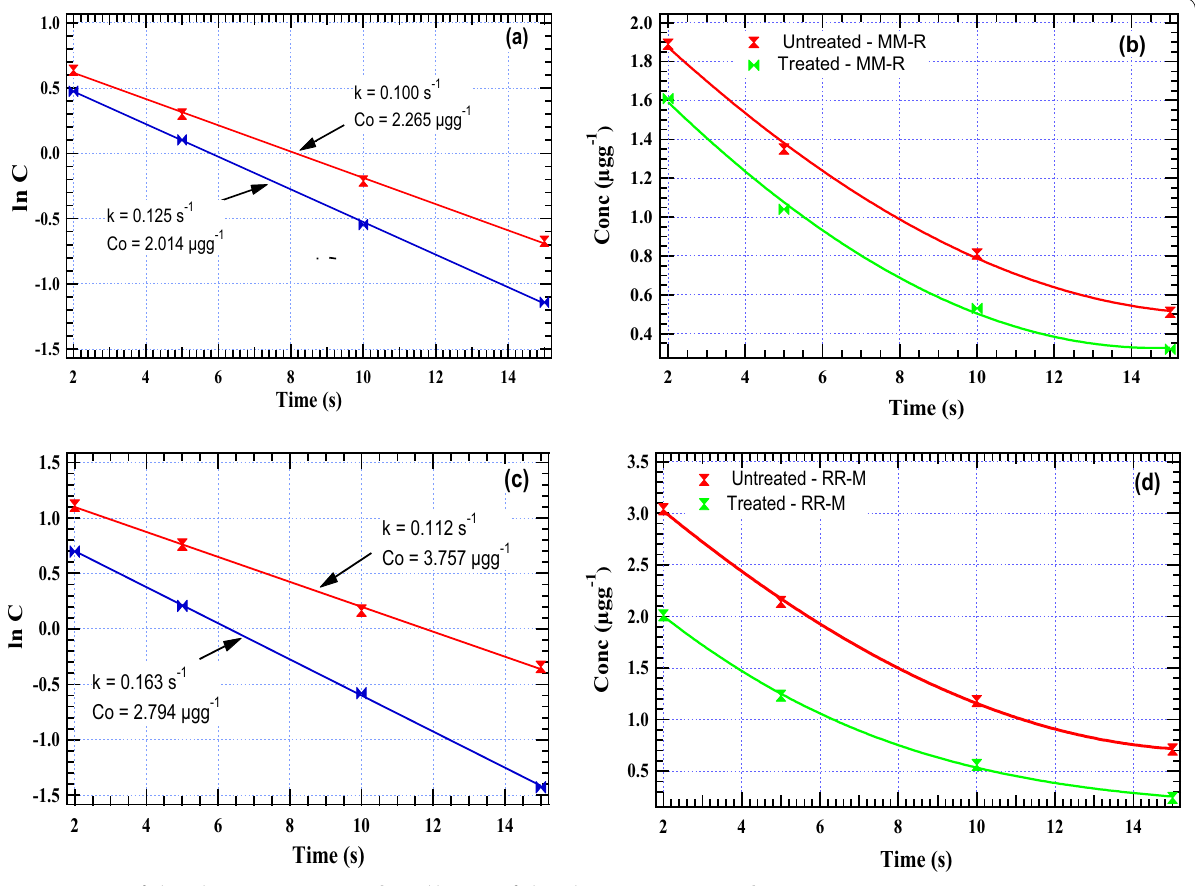
Fig. 5 Kinetics of phenol in MM-R cigarette ( a , b ) and kinetics of phenol in RR-M cigarette ( c , d )